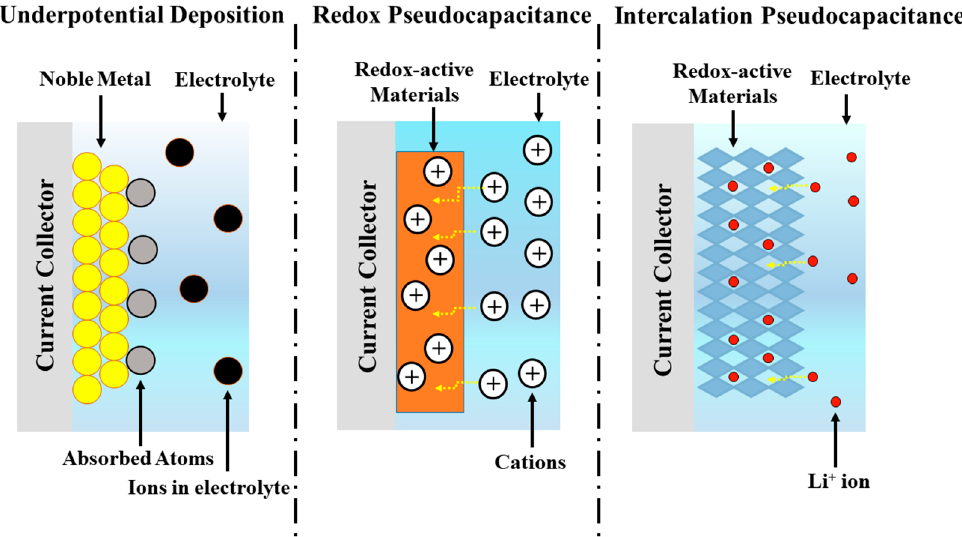
Figure 3. Working mechanisms of pseudocapacitive electrodes. Red, black, grey and yellow squares represent redox-active materials, ions in electrolyte, absorbed atoms, and noble metal respectively. Yellow and black arrows indicate the direction of ion movement and object marking. Reproduced with permission from [59] Copyright 2018, American Chemical Society.